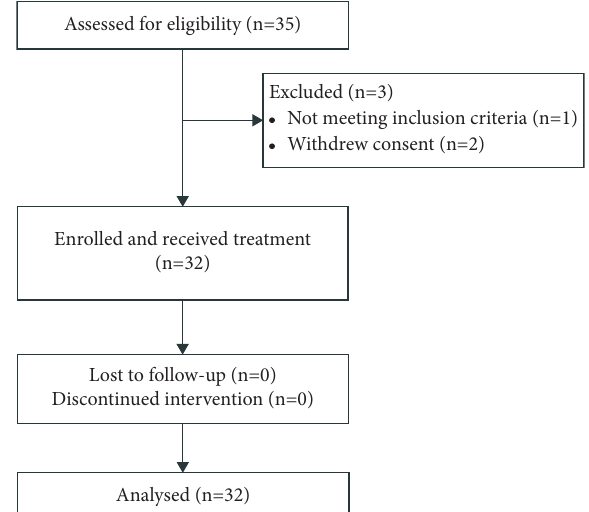
Figure 1: Study enrollment and patient flow. Diagram of the 35 patients screened for eligibility. One patient was ineligible due to Richter’s transformation during screening period. Two patient’s voluntary withdrew consent prior to